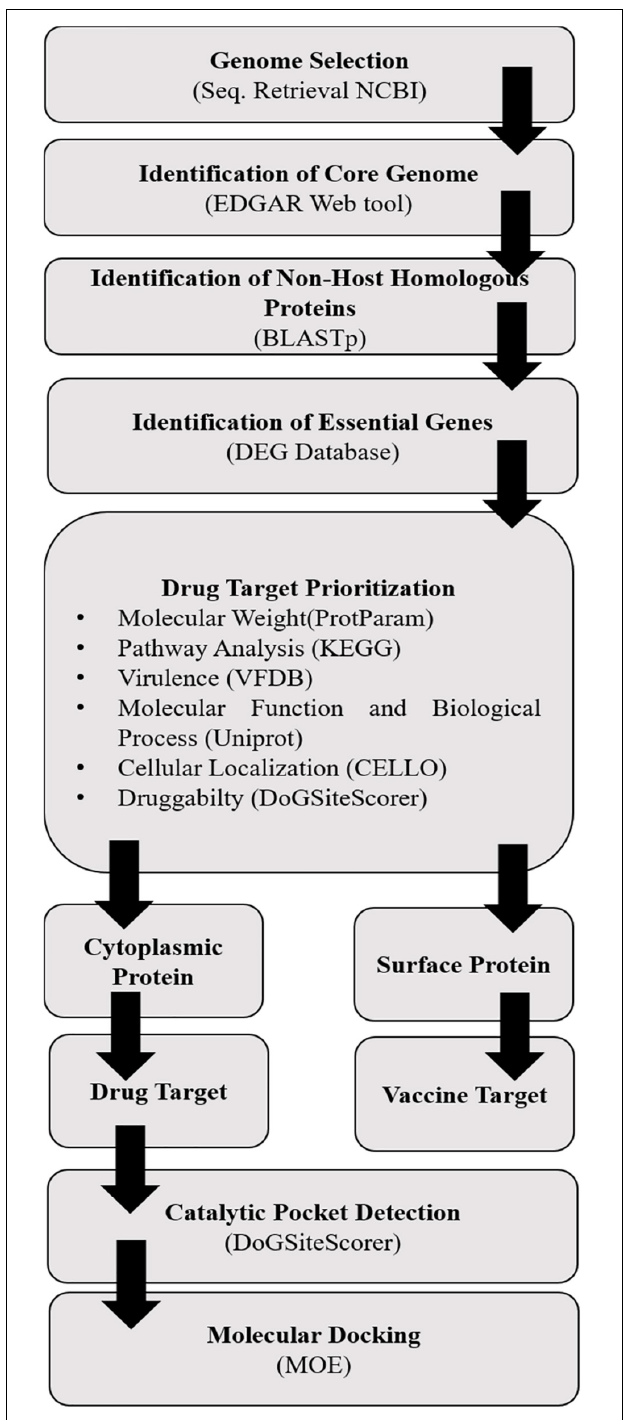
FIGURE 1 | Complete workflow of drug target identification in Sg using in silico approaches.